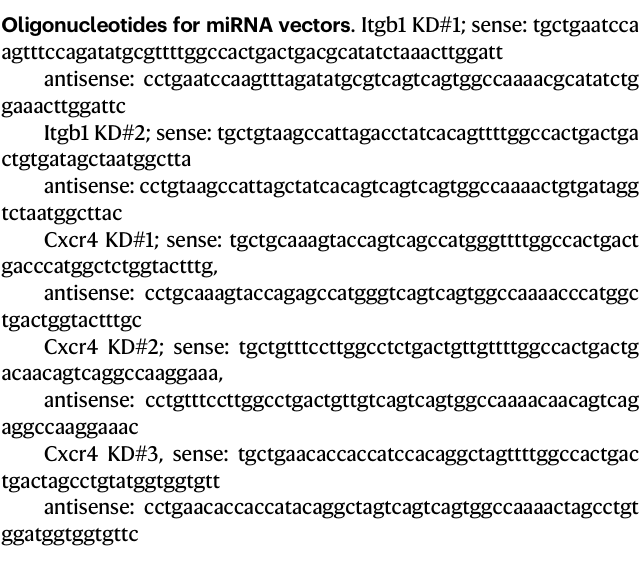
Figure 1a: pCAG-LNL-EGFP (0.5 µ g/ µ l) + pCAG-LNL-LynEGFP Figure 1d: pCAG-kikGR (2 µ g/ µ l) Figure 1f: hGFAP-Cre (0.5 µ g/ µ l) + pPB-CAG-LNL-turboRFP Figure 2c: pCAG-hyPBase (0.5 µ g/ µ l) + pPB-CAG-LNL-turboRFP (0.5 µ g/ µ l) Figure 3a and Supplementary Fig. 6a – c: rDIO system = pPB-CAG-